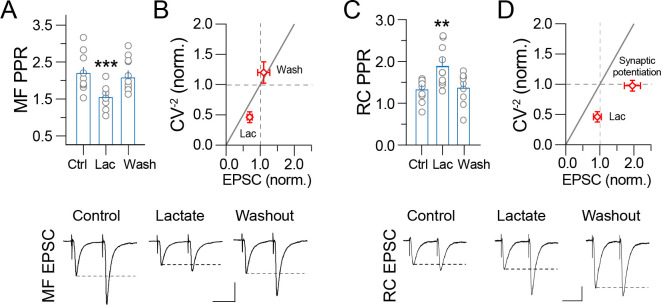
Presynaptic modifications triggered by lactate perfusion.Analysis of the paired-pulse ratio and CV-2 of the A–B) MF EPSC and C–D) RC EPSC in control conditions, during lactate (2 mM) perfusion, and at 30 min lactate washout. Lactate perfusion shifts the CV-2 below the identity lines (horizontal and diagonal lines), indicating presynaptic action. The lower panels show representative paired-pulse EPSC evoked with an ISI of 70 ms (One-way ANOVA on ranks, Tukey, *p < 0.05). Calibration bars, 50 pA / 50 ms.